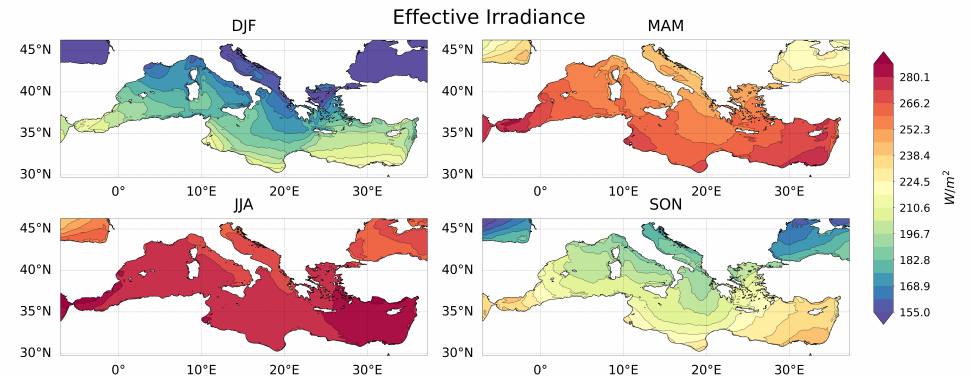
Figure 10. Seasonally averaged effective irradiance calculated from with the pvlib python package and WRF/ORCHIDEE shortwave radiation data.